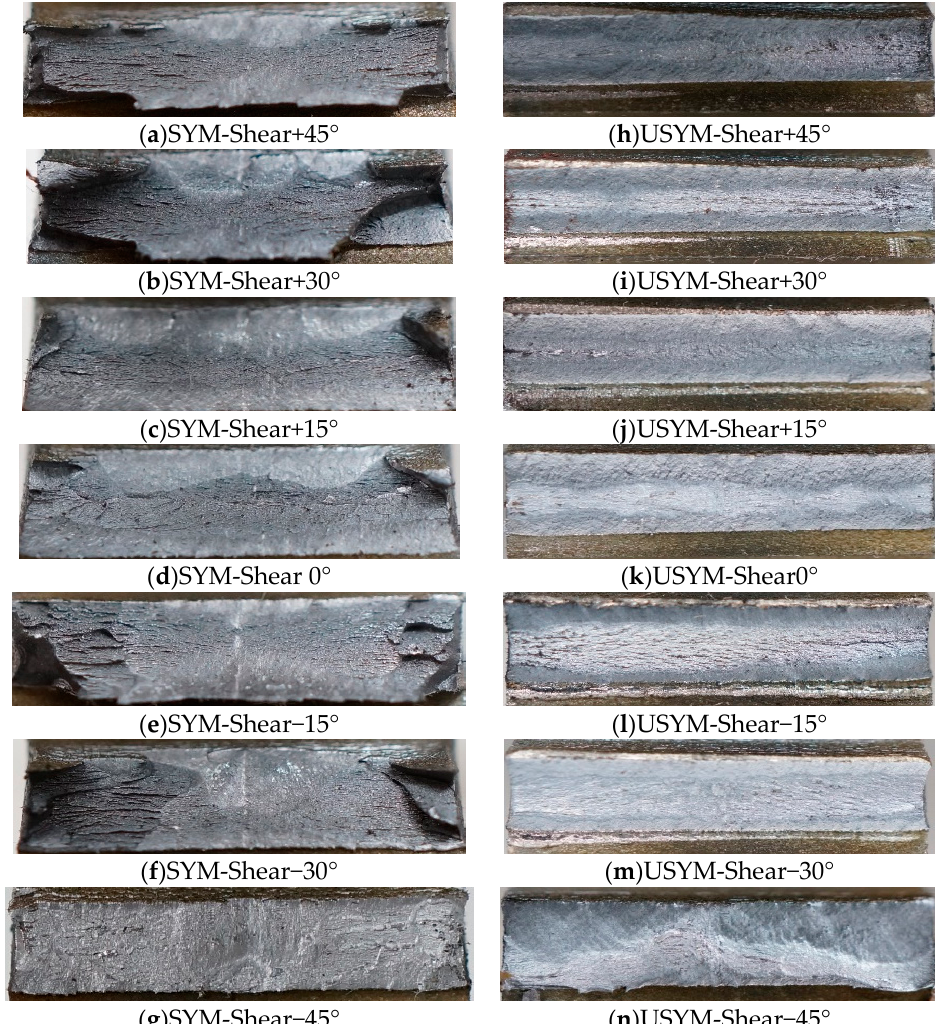
Figure 10. Photographs of failure surface of the SM570 specimens.